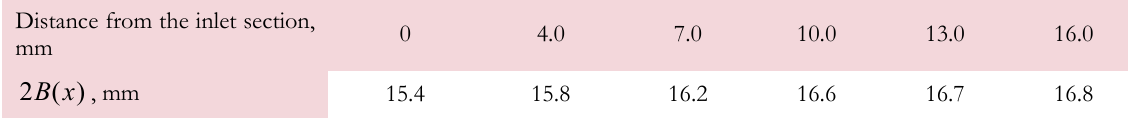
Table 3: Measurer width of the sample in the deformation zone (experiment 2).